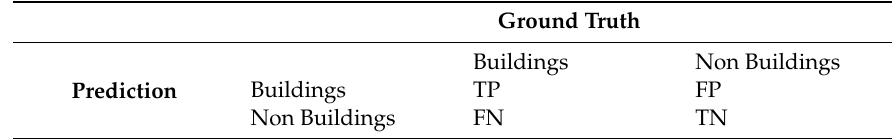
Table 1. F 1 -score calculation from confusion